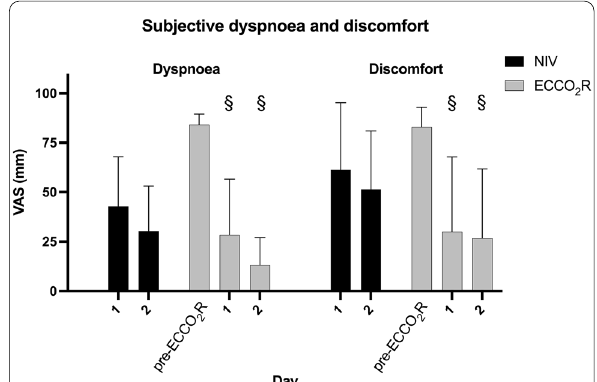
Fig. 4 Change in dyspnoea and discomfort according to the visual analogue scale where 0 is least dyspnoeic/uncomfortable and 100 is most dyspnoeic/uncomfortable (§ p <0.05 difference between measurement and baseline within in the ECCO2R